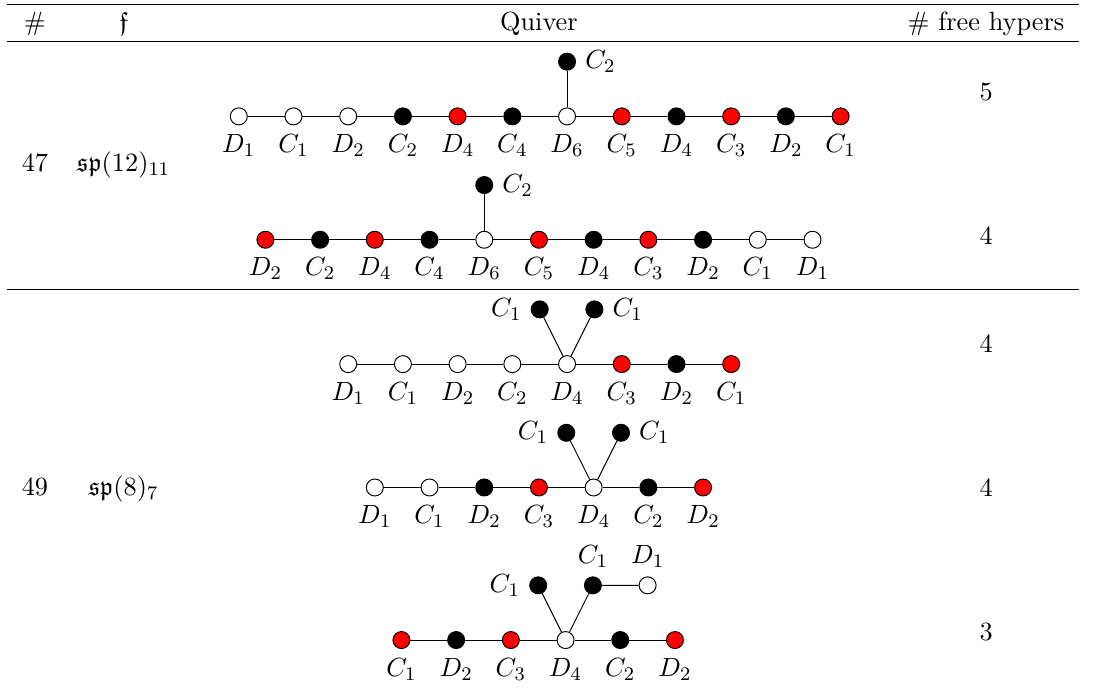
Table 7 . Magnetic quivers for theories 47 and 49. The 3d Coulomb branch of the quivers corre- sponds to the Higgs branch of the theories, plus a number of free hypermultiplets, given in the last column. Red nodes are underbalanced, white nodes are balanced and black nodes are